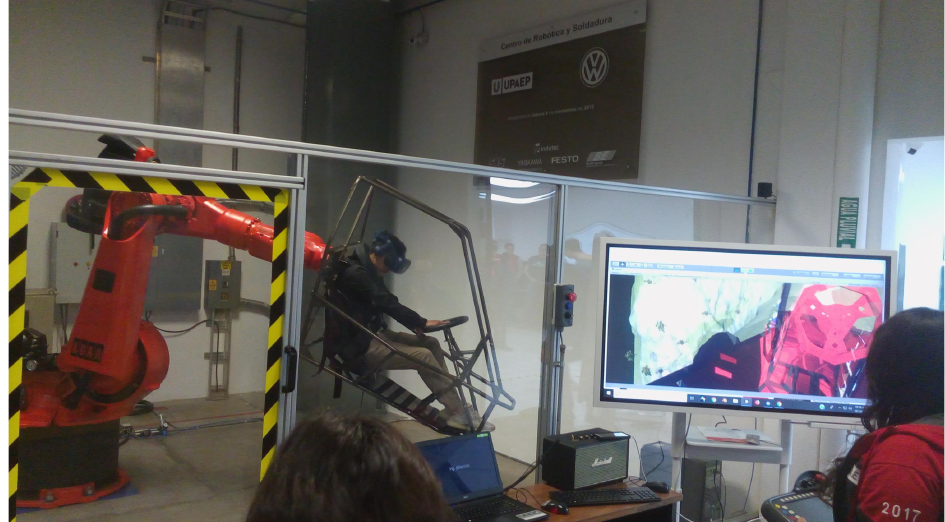
Figure 3. Automotive design testing in the VR/AR laboratory at UPAEP: room B